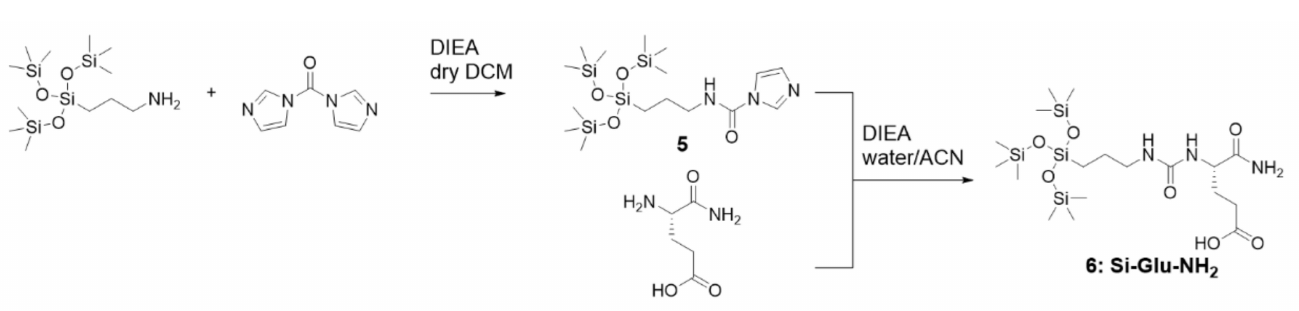
Figure 4. Silylation of isoglutamine with N-[3-tris(trimethylsiloxy)silylpropyl]-imidazole-1-carboxamide ( 5 ).